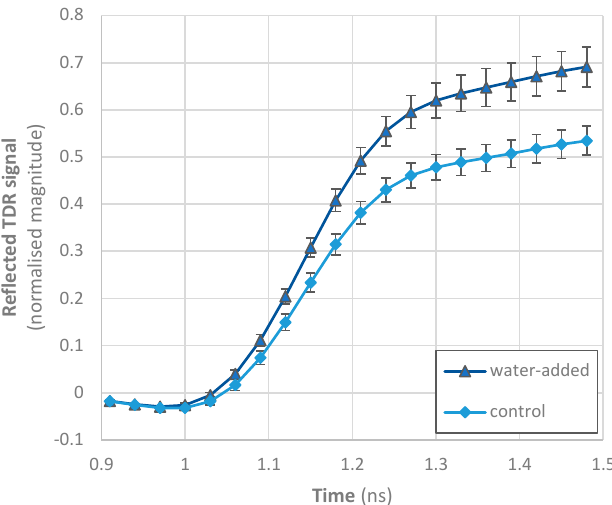
Figure 3. Time domain reflectometry data of Octopus vulgaris samples. Immersion time of water- added treatments varied from 0.5 to 32 h. Data represent the average and standard deviation of all samples of calibration trials.